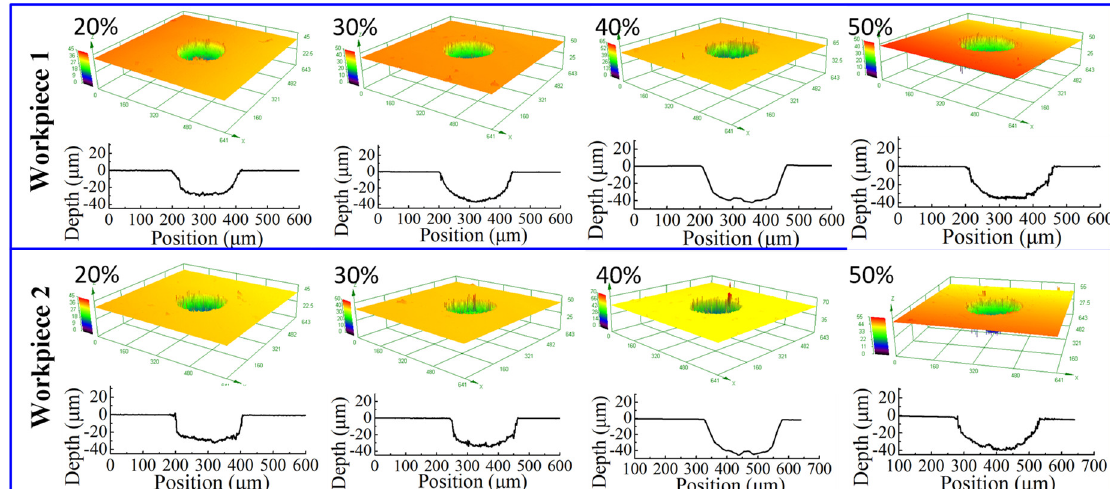
Figure 13. The effect of pulse duty cycle on the dimension of micro dimples. ( a ) Diameter; ( b ) Depth.